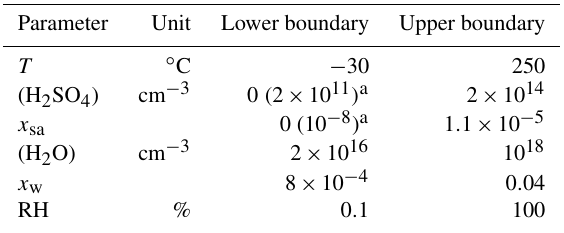
Table 5. The environmental parameter ranges within which the nu- cleation rate function was